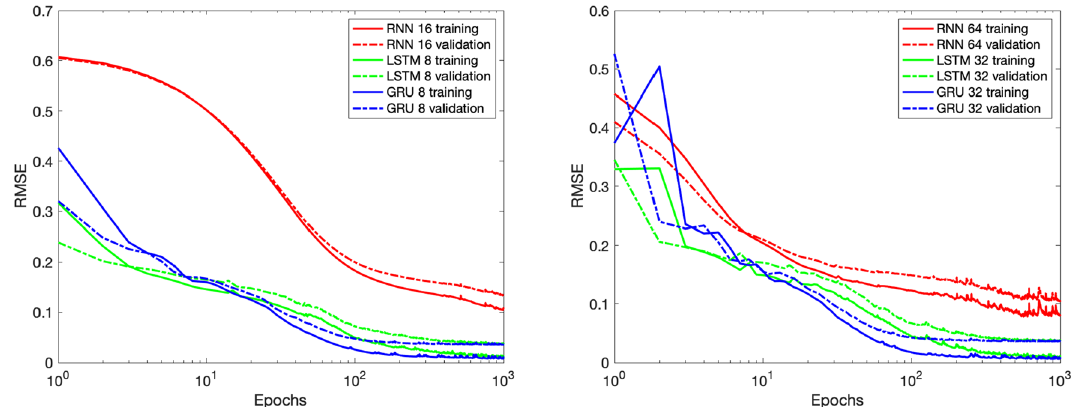
Figure 5. Average training and validation RMSE out of ten simulations, with recurrent layers of size 16 and 8 (left) and 64 and 32